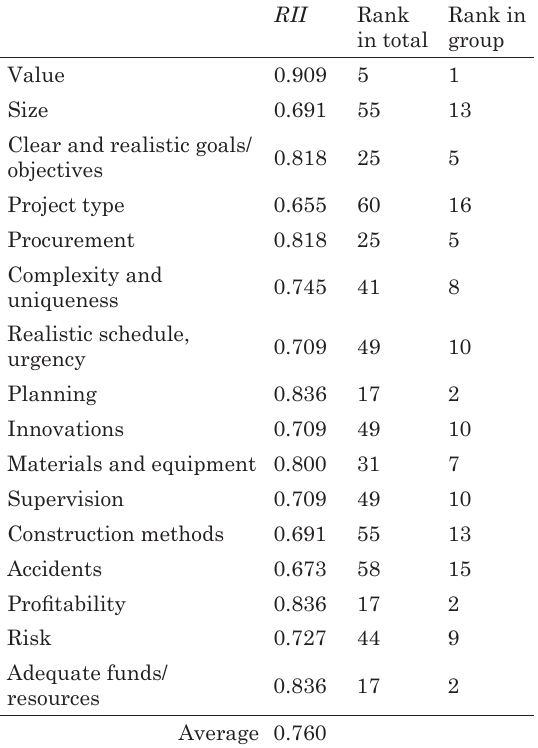
table 3. Summary of survey results on project